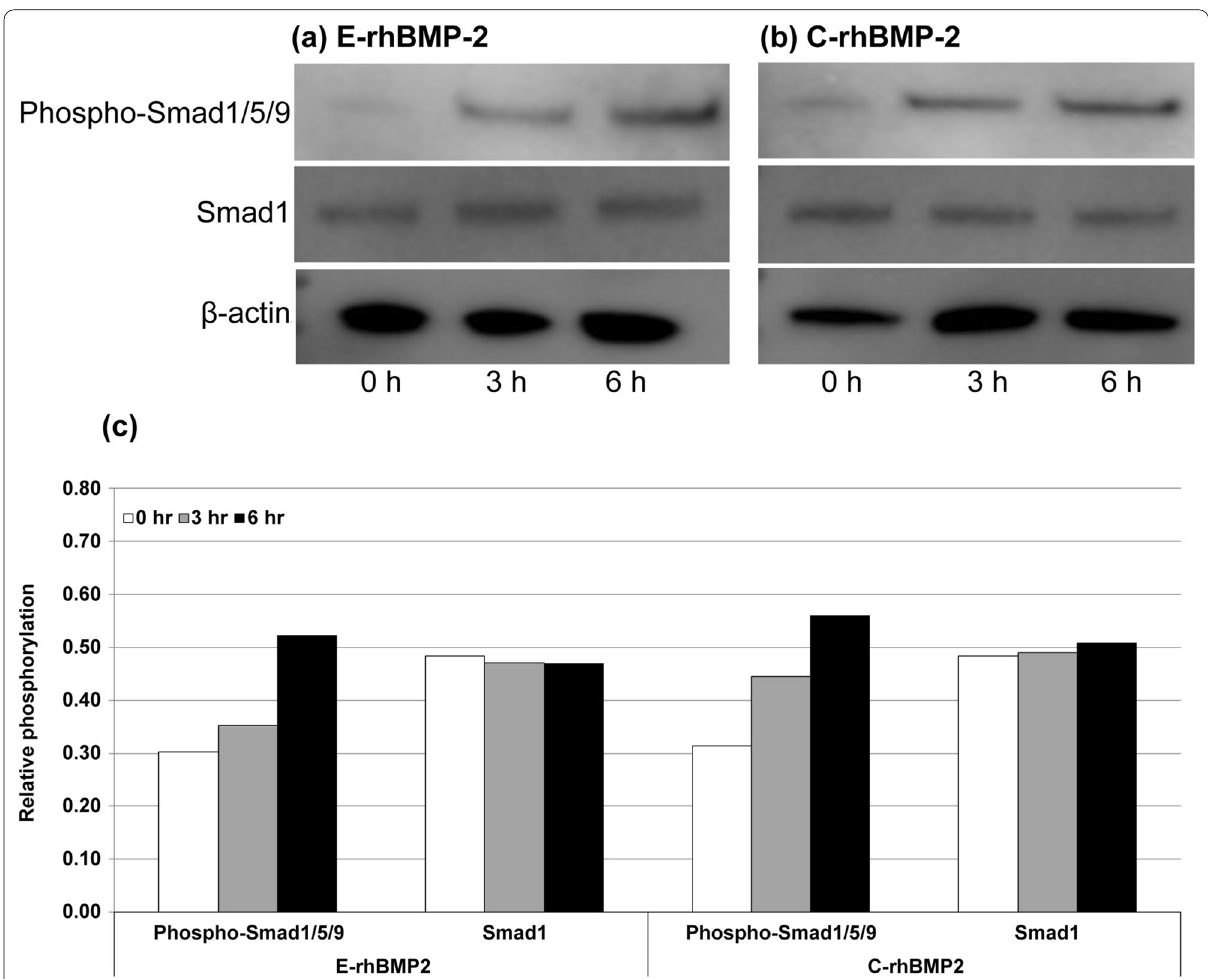
Fig. 1 Effects of E‑rhBMP‑2 and C‑rhBMP‑2 on intracellular receptor‑regulated Smads in C2C12 cells. A total of 0.2 mg protein was loaded onto each lane and anti‑phospho‑Smad1/5/9 antibody was applied to detect the phospho‑Smad1/5/9. Bands for Smad1 and β‑actin are shown as the loading control. Bands were detected using Amersham Imager 600 (GE Healthcare). a E‑rhBMP‑2, Escherichia coli ‑derived recombinant human bone morphogenetic protein‑2; b C‑rhBMP‑2, rhBMP‑2 derived from CHO cell; c Relative phosphorylation was calculated normalizing the quantification values of phospho‑Smad1/5/9 and Smad1 band intensity to the β‑actin band